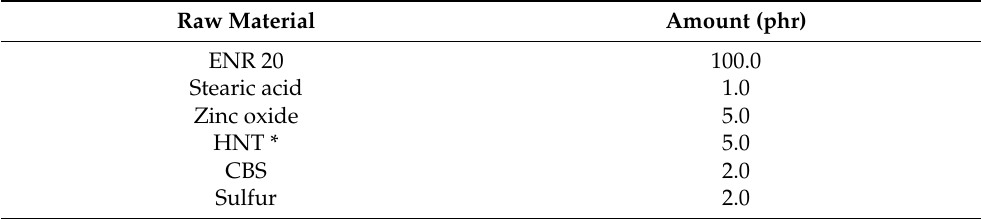
Table 1. Formulation of ENR composites filled with untreated and acid-treated